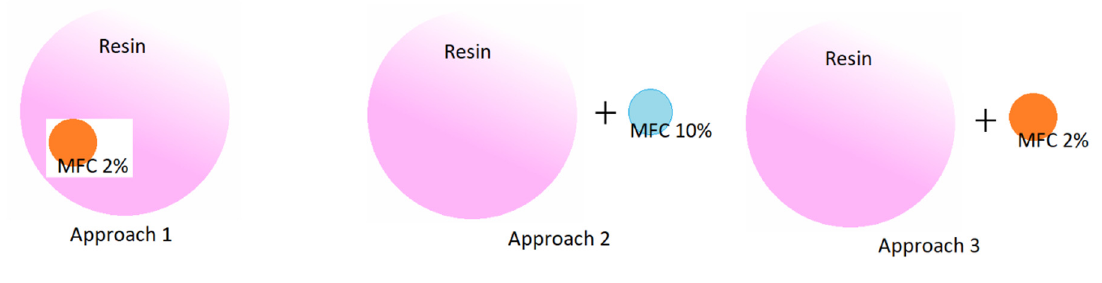
Figure 1. Approaches of introduction of MFC into adhesive systems.